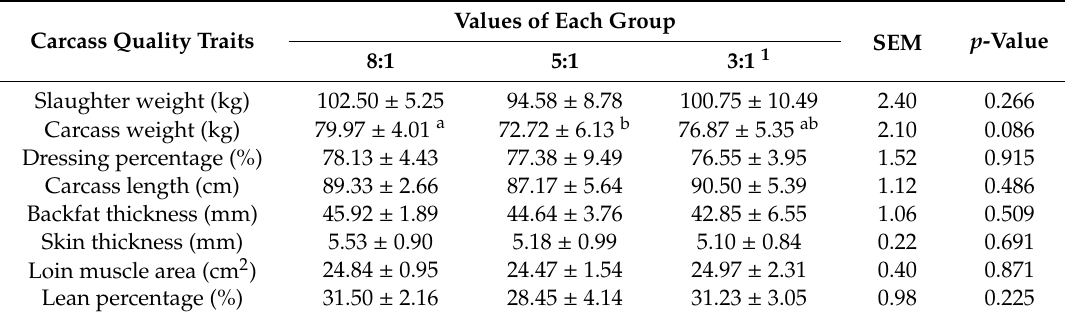
(Table 4). Pigs fed the dietary n-6 / n-3 PUFA ratio of 8:1 had the lowest pH (24 h) ( p < 0.05) and L* (24 h) ( p < 0.05), but had the highest ∆ pH ( p < 0.01), a* (45 min) ( p < 0.01), a* (24 h) ( p < 0.01), b* (24 h) ( p < 0.01), ∆ a* ( p < 0.01), and ∆ b* ( p < 0.01). The remainder of the parameters evaluated (pH (45 min), drip loss, marbling score, meat color score, intramuscular fat, 45 min L*, 45 min b*) were not significantly a ff ected by the treatments ( p >